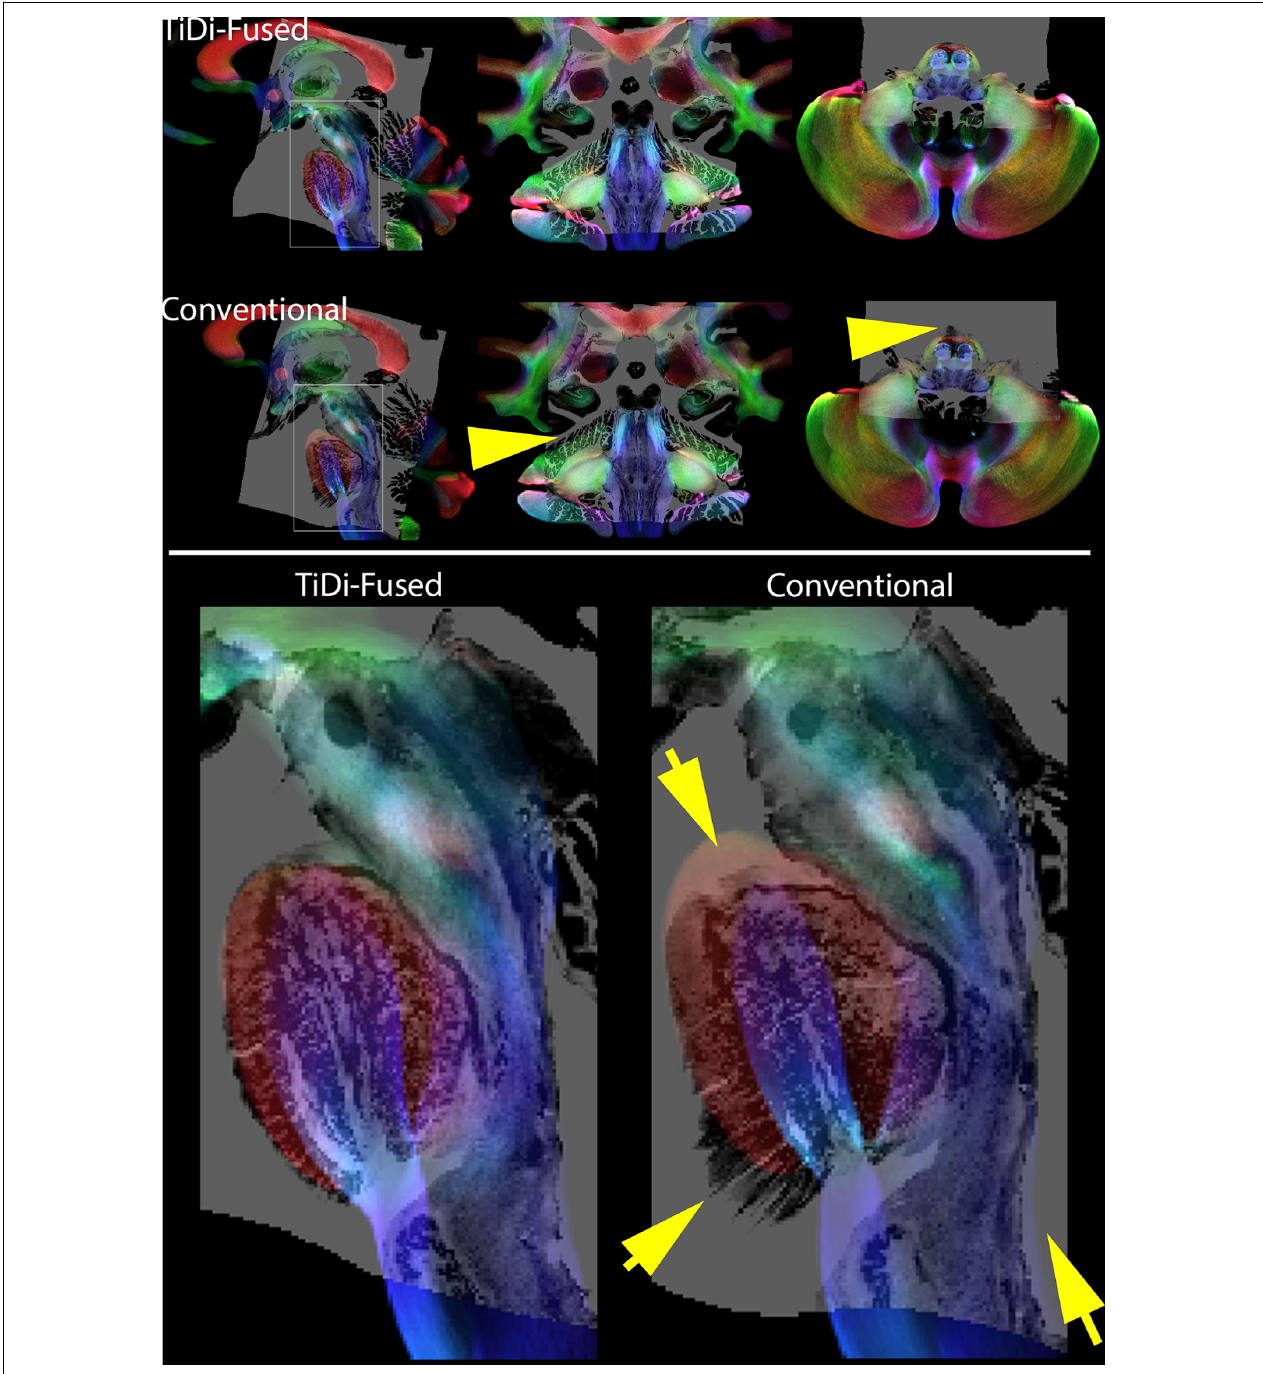
FIGURE 2 | Histology overlays on TDI. Top panel: Histology on Track Density Imaging maps resulting from each of the two pipelines—sagittal (right), coronal (middle), and axial (left). Bottom panel: Amplified sagittal view of histology on TDI in brainstem highlights the better spatial alignment resulting from TiDi-Fused. Note the arrows pointing to areas were the conventional pipeline leads to badly aligned regions with histology. In contrast, using TiDi-Fused leads to a mapping of histology that is much better supported by the underlying TDI contrast.